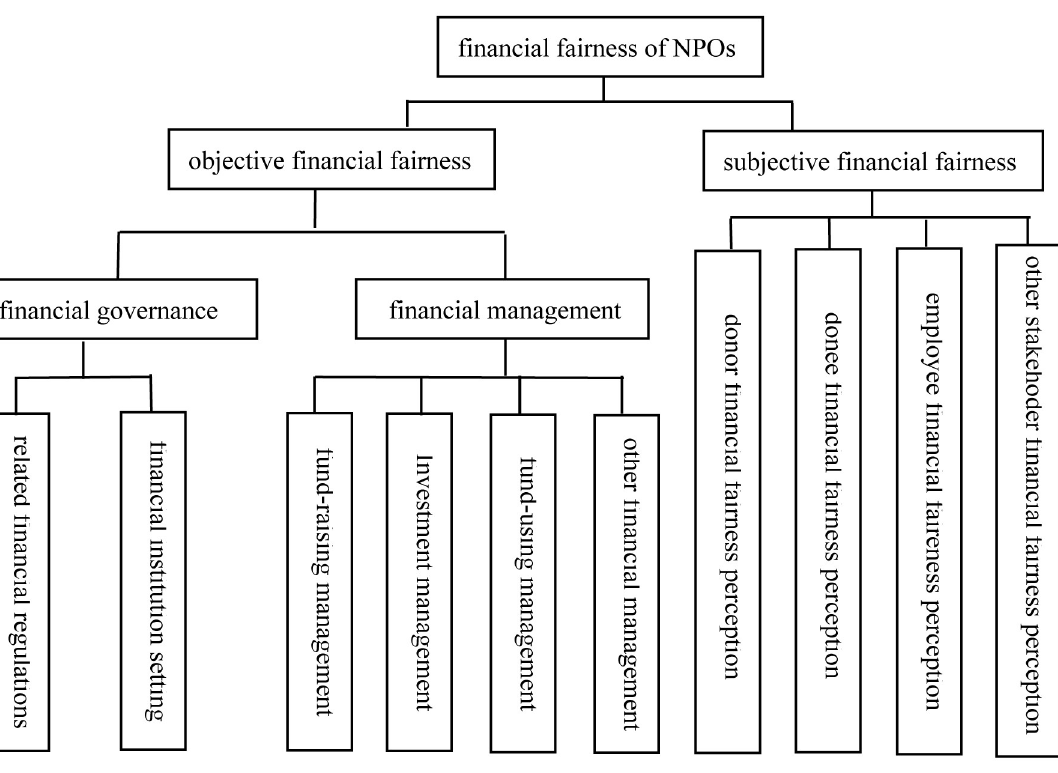
Fig 2. The financial fairness frame of